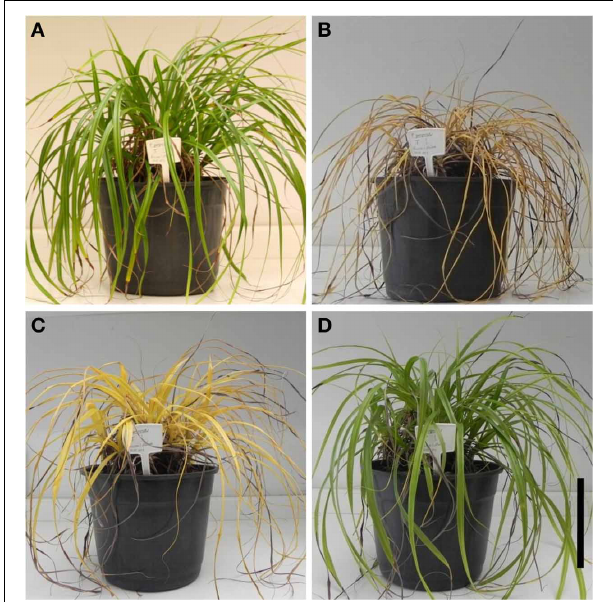
FIGURE 1 | General appearance of the plants of Barbacenia purpurea along the dehydration and rehydration. Aspect of the daily watered plants (A) and plants under water suppression (B) and rehydration (C,D) during the winter season. Plants of 0 days (A) and 20 days (B) of dehydration and 12h (C) and 38h (D) after rehydration. Scale bar =